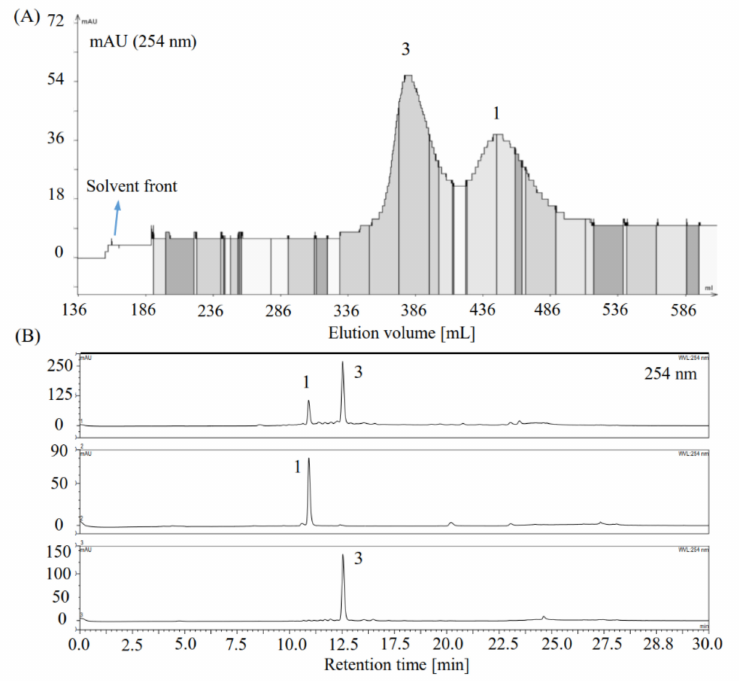
Figure 4. Chromatograms of conventional HCCC separation and HPLC detection of the target compounds 1 and 3 . ( A ) HSCCC separation of the target compounds 1 and 3 from their mixture using the 8.7 mM acetic acid-modified n -BuOH/H 2 O (1:1, v / v ) solvent system. The partitioned upper and lower phases of the 8.7 mM acetic acid-modified n -BuOH/H 2 O (1:1, v / v ) solvent system were used as the mobile and stationary phases, respectively. Revolution speed 850 rpm; mobile phase flow rate: 5 mL/min; UV detection wavelength 254 nm. ( B ) HPLC chromatograms (254 nm) of the mixture of compounds 1 and 3 and the separated compounds by